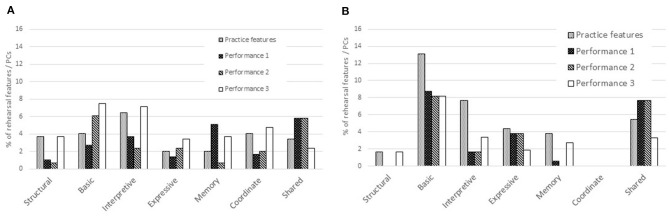
Percentages of rehearsal features that remained or became salient in performances from memory: viola player (A) and singer (B).